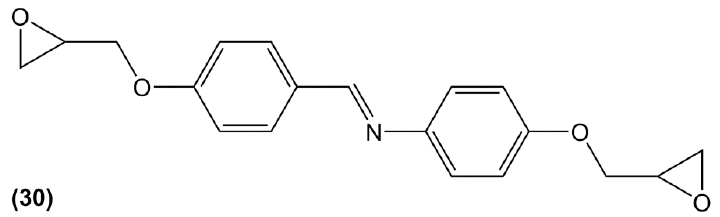
Figure 21. Epoxy resin based on p -aminophenol and p -hydroxybenzaldehyde synthesized by Duann et al. [161].